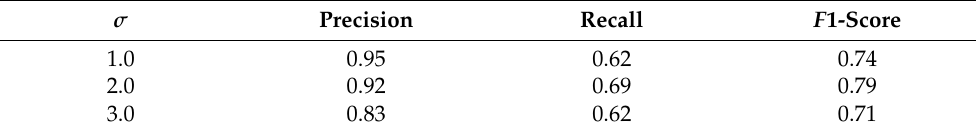
Figure 6. Confidence map generated with different σ values. ( a ) Ground truth of SDTs; ( b ) The confidence map when σ is 1; ( c ) The confidence map when σ is 2; ( d ) The confidence map when σ is 3. The accuracy with different σ in our research area is listed in Table 3. The best result was obtained for σ = 2.0, which is better fitted to the size of the tree canopy in this case. Table 3. The evaluated σ on generating the confidence map to train with the MSSCN model. σ Precision Recall F 1-Score